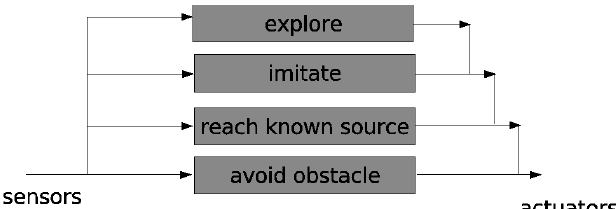
Figure 2. Subsumption-like [50] architecture for action selection mechanism in the